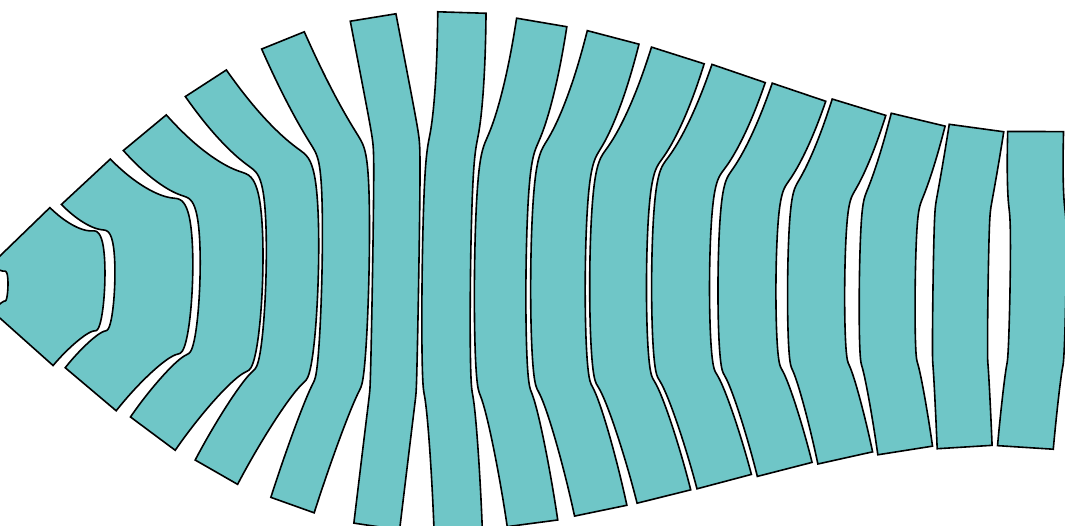
Figure 20. Developed surface created with method four. This is the 3D shape shown in Figure